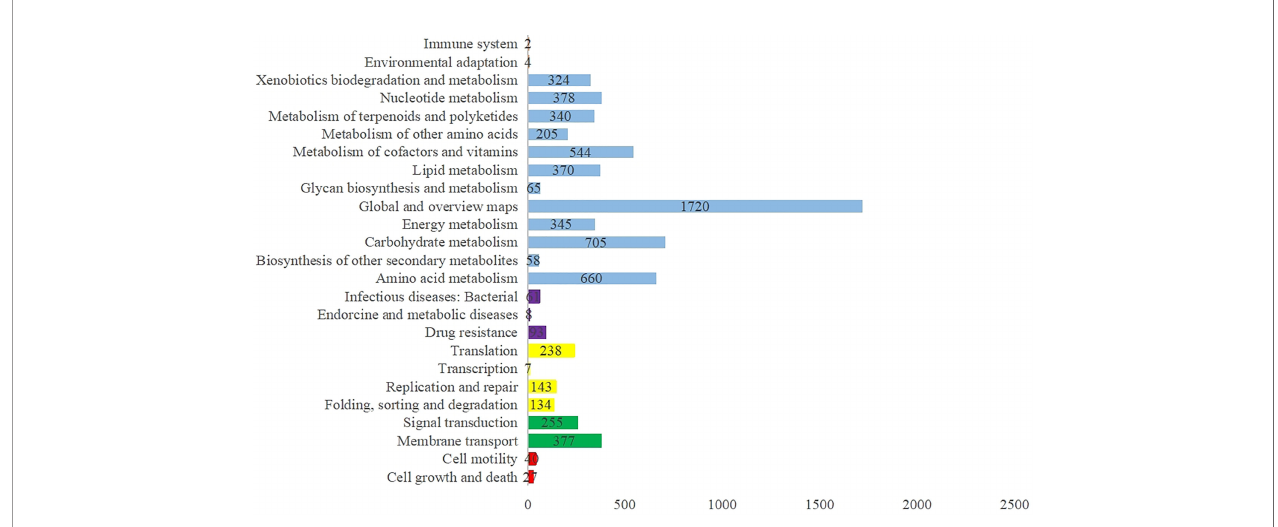
FIGURE 2 | Distribution of KEGG pathways in the M. saopaulense strain ’ s genome, showing the top fi ve KEGG Orthology (KO) categories in the assigned sequences, which include organismal systems (orange), metabolism (blue), human diseases (purple), genetic information processing (yellow), environmental information processing (green), and cellular process